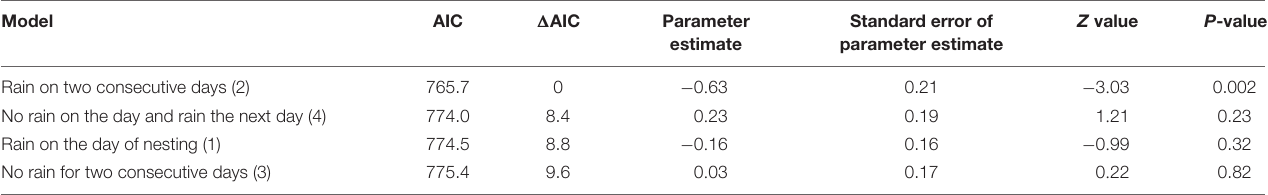
TABLE 3 | Summary of the four regression models fitted to the data, each including a different rainfall variable as predictor (see section Methods). Model AIC (cid:49) AIC Parameter